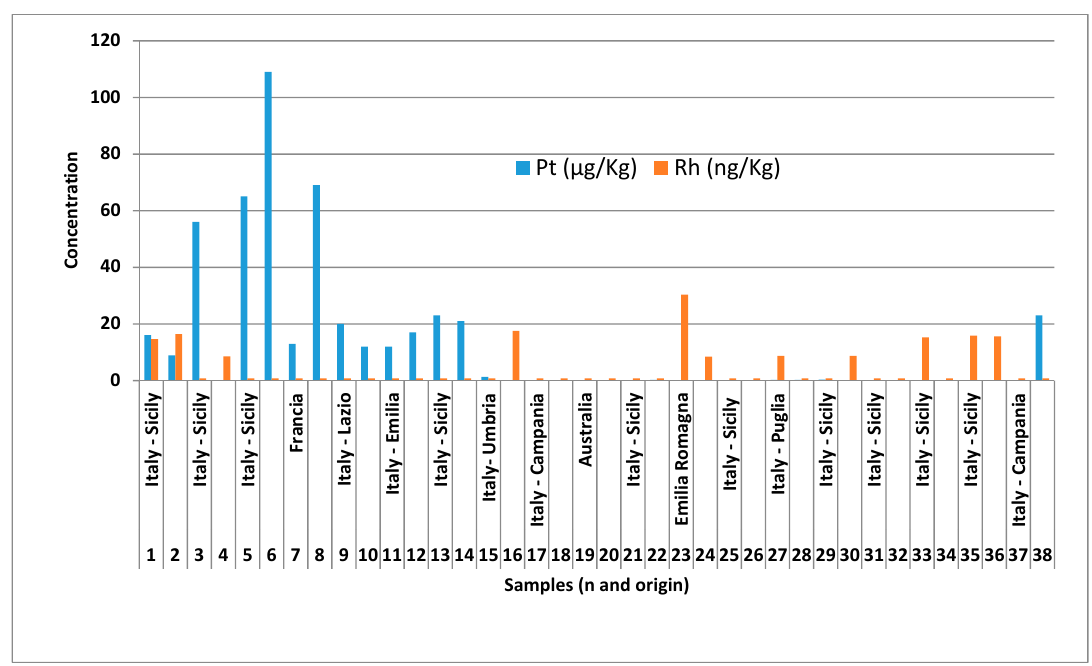
Figure 3. Platinum and rhodium concentrations in potato samples.